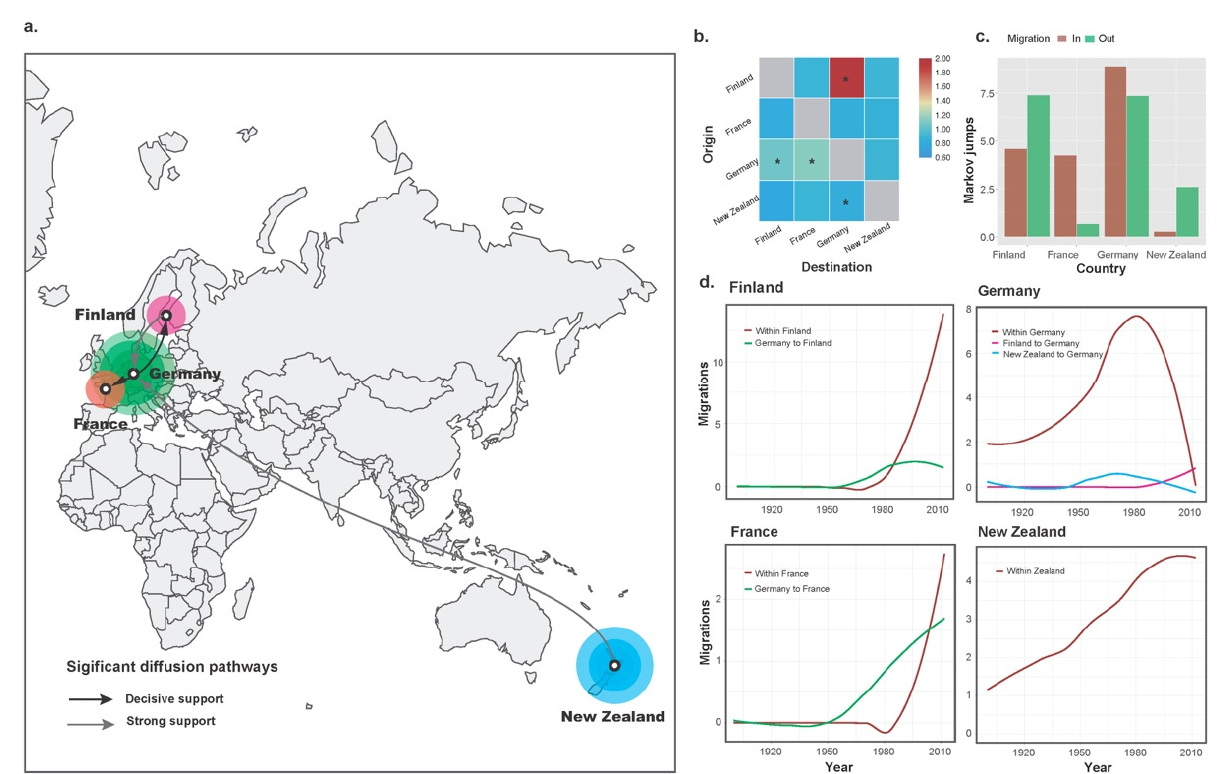
Figure 2. Dispersal patterns of viral migration inferred from cherry leaf roll virus isolates collected from four countries. ( a ) Migration pathways among countries. Arrows represent statistically sup- ported migration rates. ( b ) Heat-maps of the mean migration rate. Significant migration events were marked with asterisks. ( c ) Histogram showing the total number of state counts for migration into and out of each country. The x -axis indicates the countries and the y -axis indicates the mean Markov jump counts (that is, the number of location state transitions). ( d ) The plots for migration to Finland, Germany, France, and New Zealand over time. The x -axes are measured in calendar years and the y-axes indicate migration events on log 10 scale.